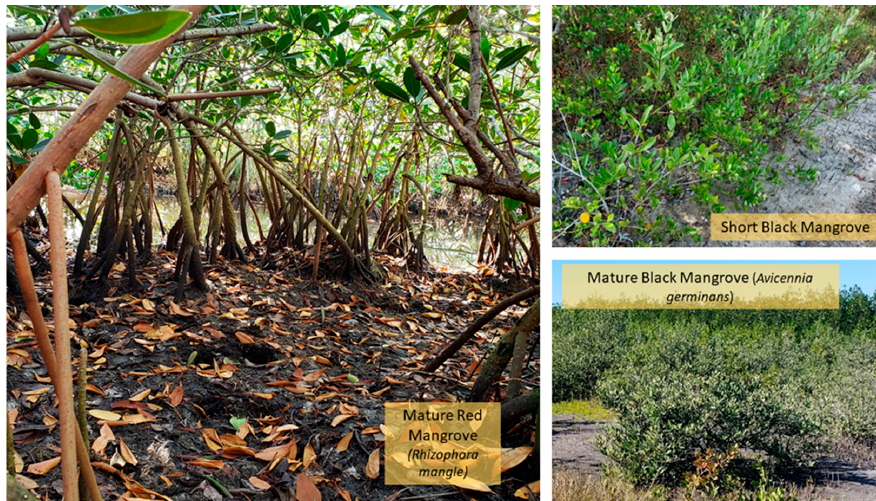
Figure 3. Mangrove species in the area and black short mangrove.